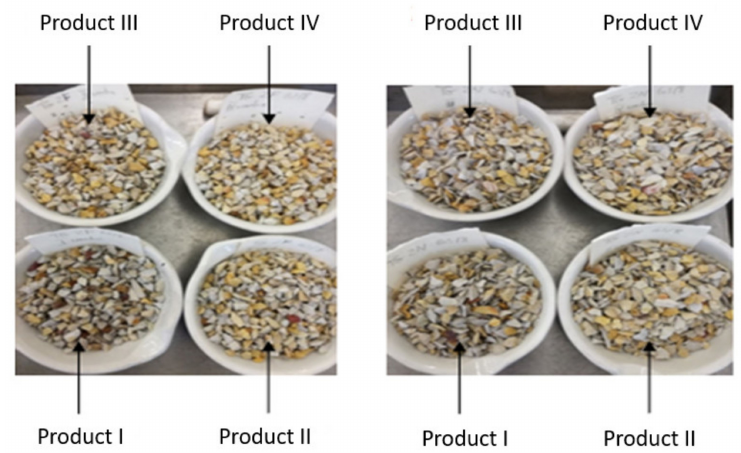
Figure 2. The exemplary chalcedonite product separated into four fractions for the regular particles ( left ) and irregular particles ( right